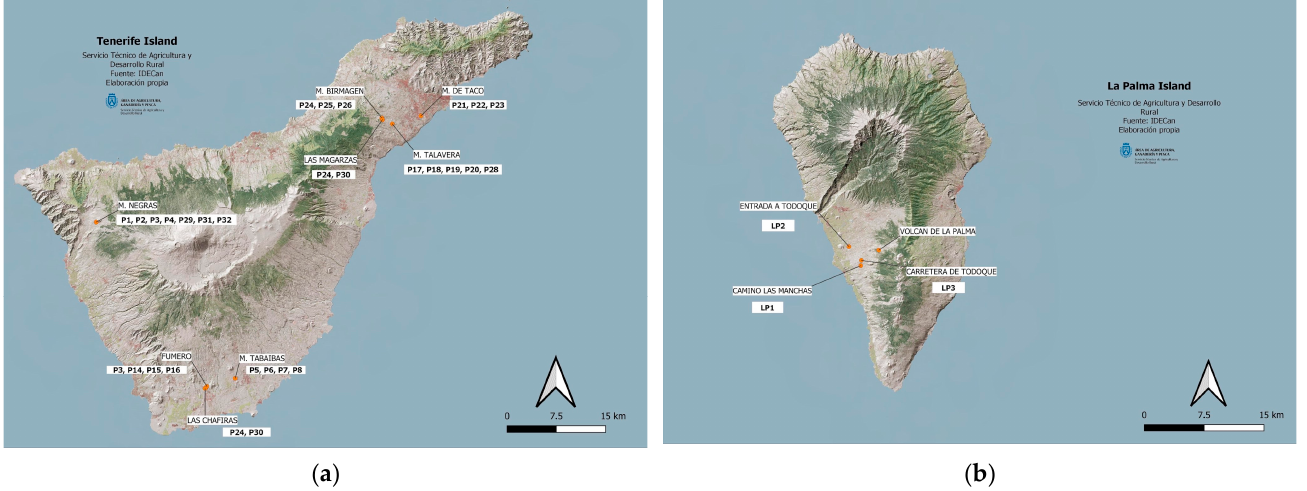
Figure 2. Distribution of the sampled tuffs: ( a ): sampled quarries and sampled tephras in Tenerife, respectively; ( b ) sampled areas in La Palma.